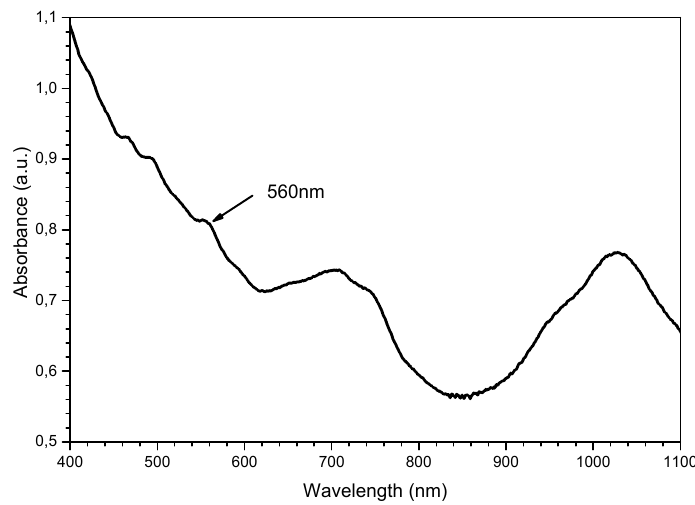
Figure 7. The absorption spectrum of the SWCNT film. The calibration lines of the sensors were determined as the linear regression of I water /I dye vs. concentration dependences, calculated using the least squares method (Figure 8b). The sensitivity of the sensor coated with SWCNTs was 317 (mg/L) − 1 dye concentration and had a slope linearity of 99.9%, while the uncoated sensor sensitivity was 32 (mg/L) − 1 with a slope linearity of 98.5%. Consequently, the sensor sensitivity was increased by a factor of 10 with the use of SWCNTs, indicating a significant improvement in sensitivity. The sensitivity boost effect of pure SWCNTs demonstrated better performance than SWCNT-polyethylene oxide composite coating [36] and showed an 8 × increase in